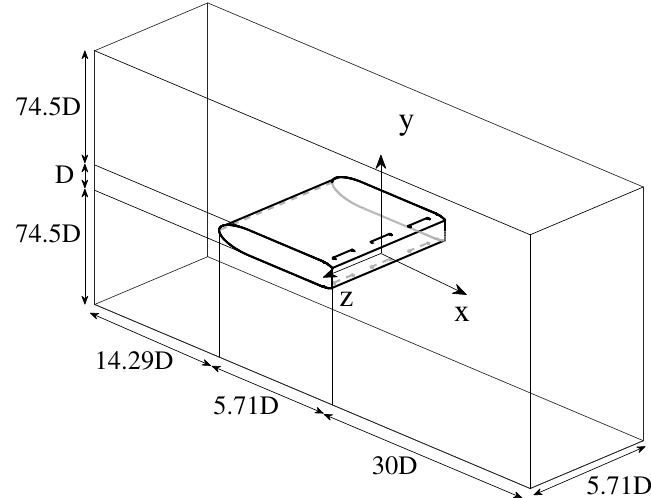
Figure 3. Sketch of the computational domain (not in